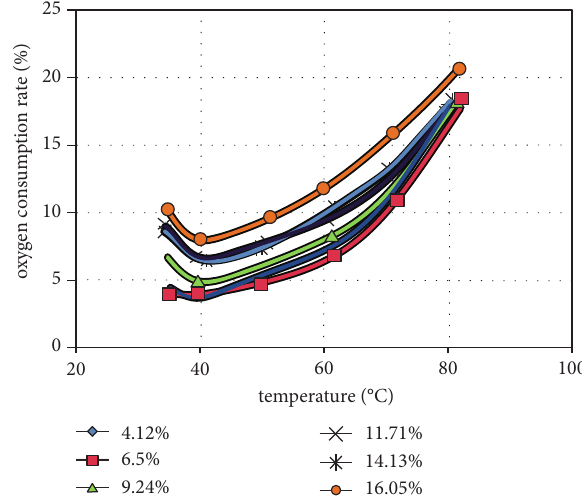
Figure 15: Evolution of CO concentration, as an index of coal spontaneous combustion, for samples with different moisture content in the temperature range of 35–80 °